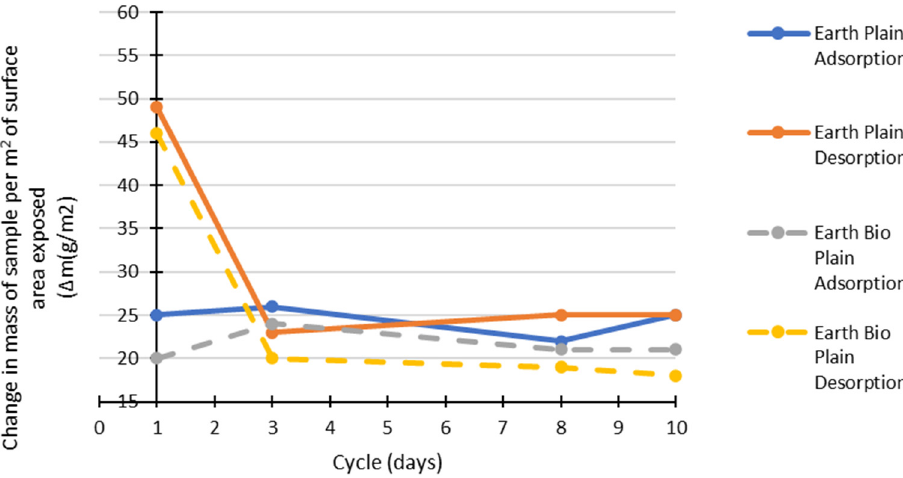
Figure 18. Adsorption and desorption change during 10 cycles for earth-based mortars with/with- out biostabiliser (bio).